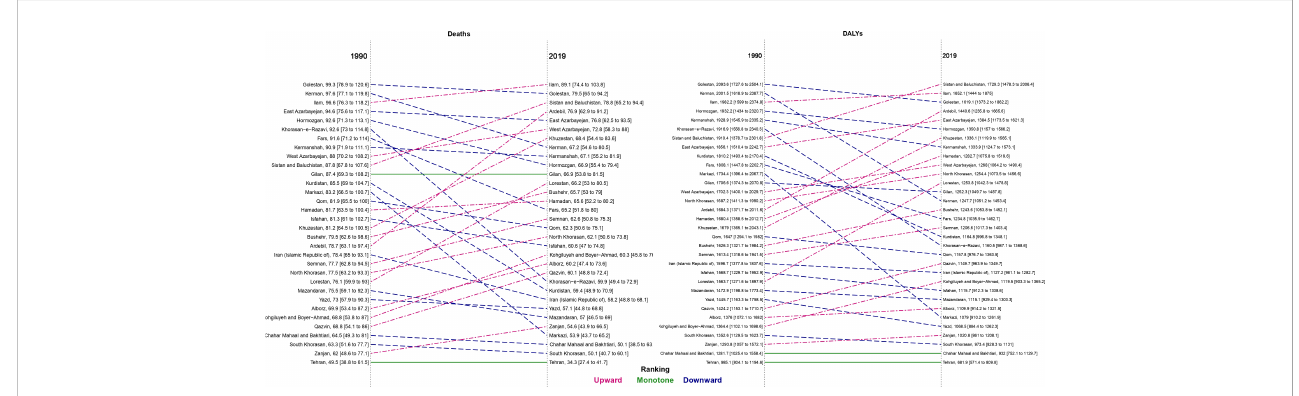
FIGURE 1 Comparison of the age-standardized rate of deaths and disability-adjusted life years (DALYs) attributable to kidney dysfunction for both sexes between 1990 and 2019 in Iran by